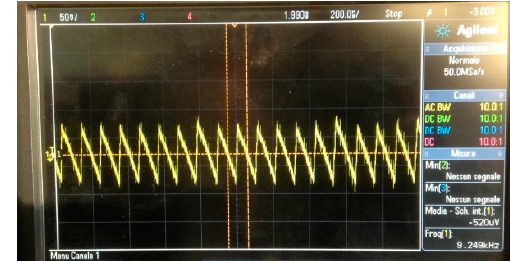
Figure 3. Power supply ripple.